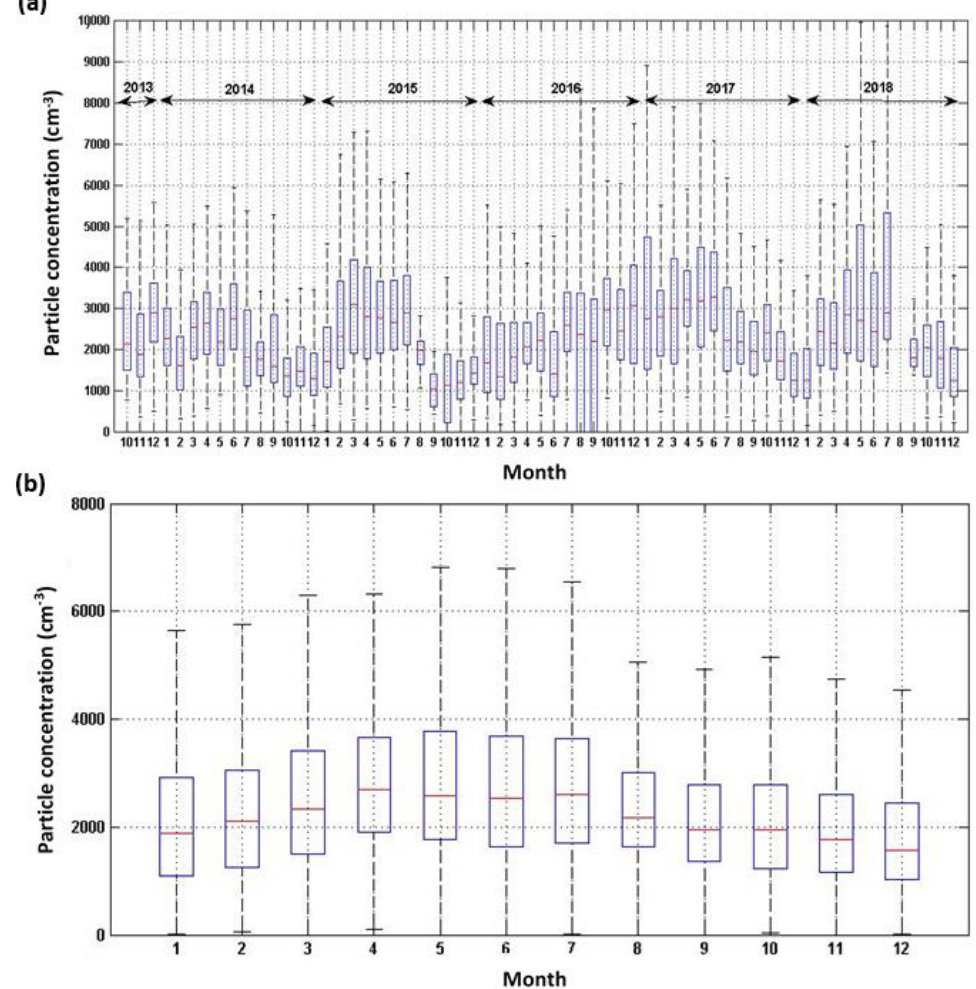
Figure 7. ( a ) Evolution of the total particle concentration (cm − 3 ) of diameter between 10 and 550 nm measured by the SMPS over the entire period; ( b ) seasonal median of this same parameter (cm − 3 ). Red lines represent the median value, bottom and top sides of the boxes symbolize the 25th and 75th percentile respectively. The length of the whiskers represents 1.5 × interquartile range which includes 99.3% of the data.